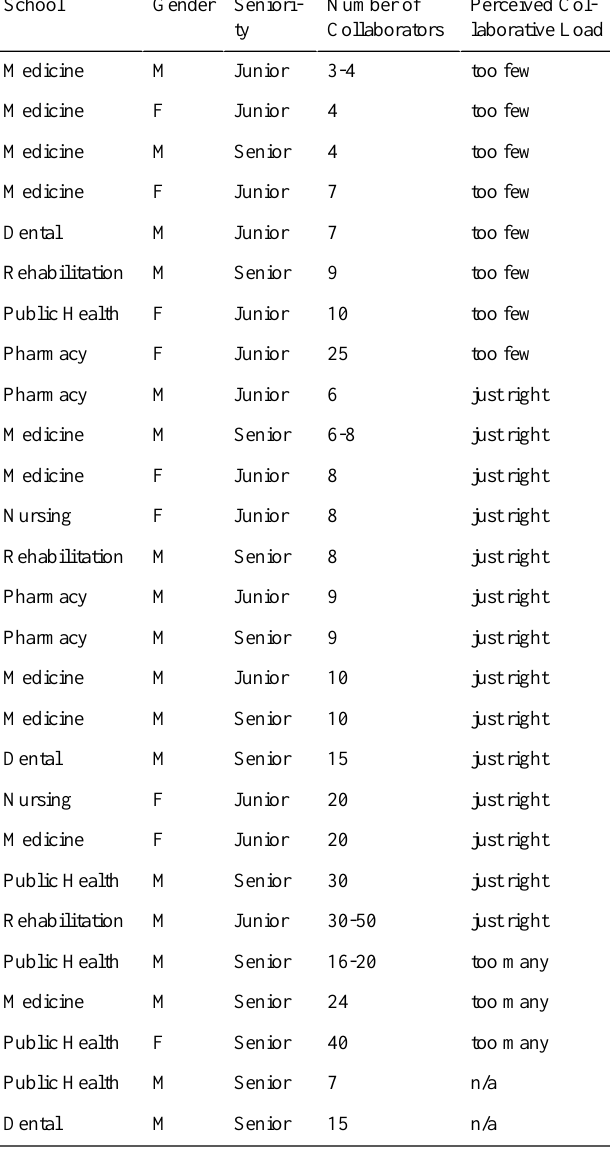
Table 1. Researcher affiliation, gender, seniority, collaborator count, and perceived collaborative